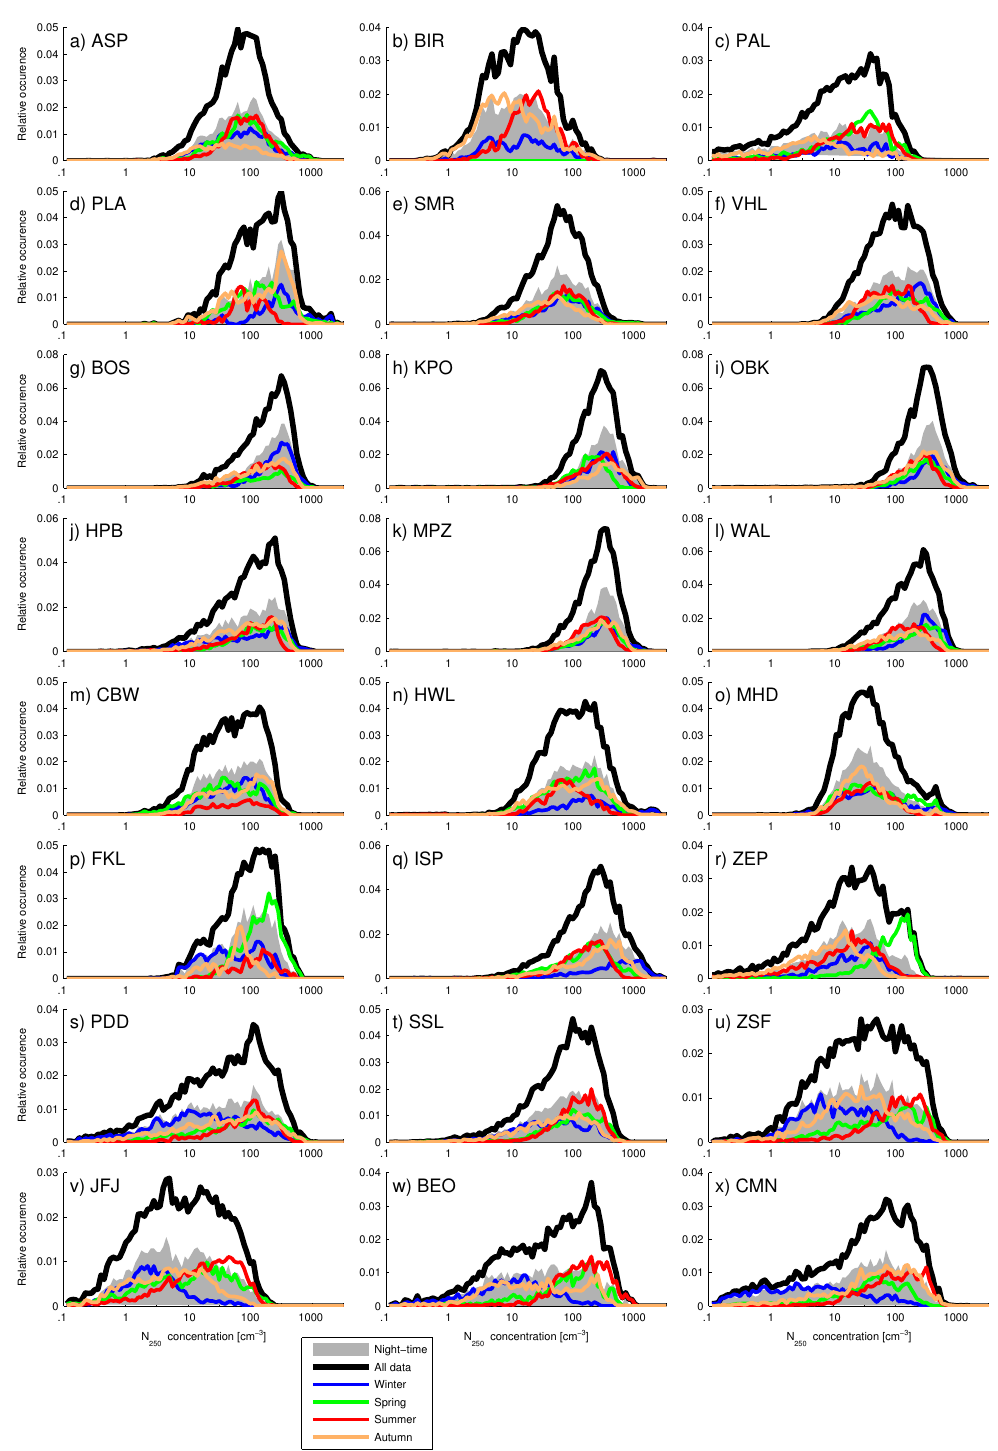
Fig. 16. Histograms of N 250 concentrations in the stations. See Fig. 9 for nomenclature. Note the different scale on x-axis compared to Figs.